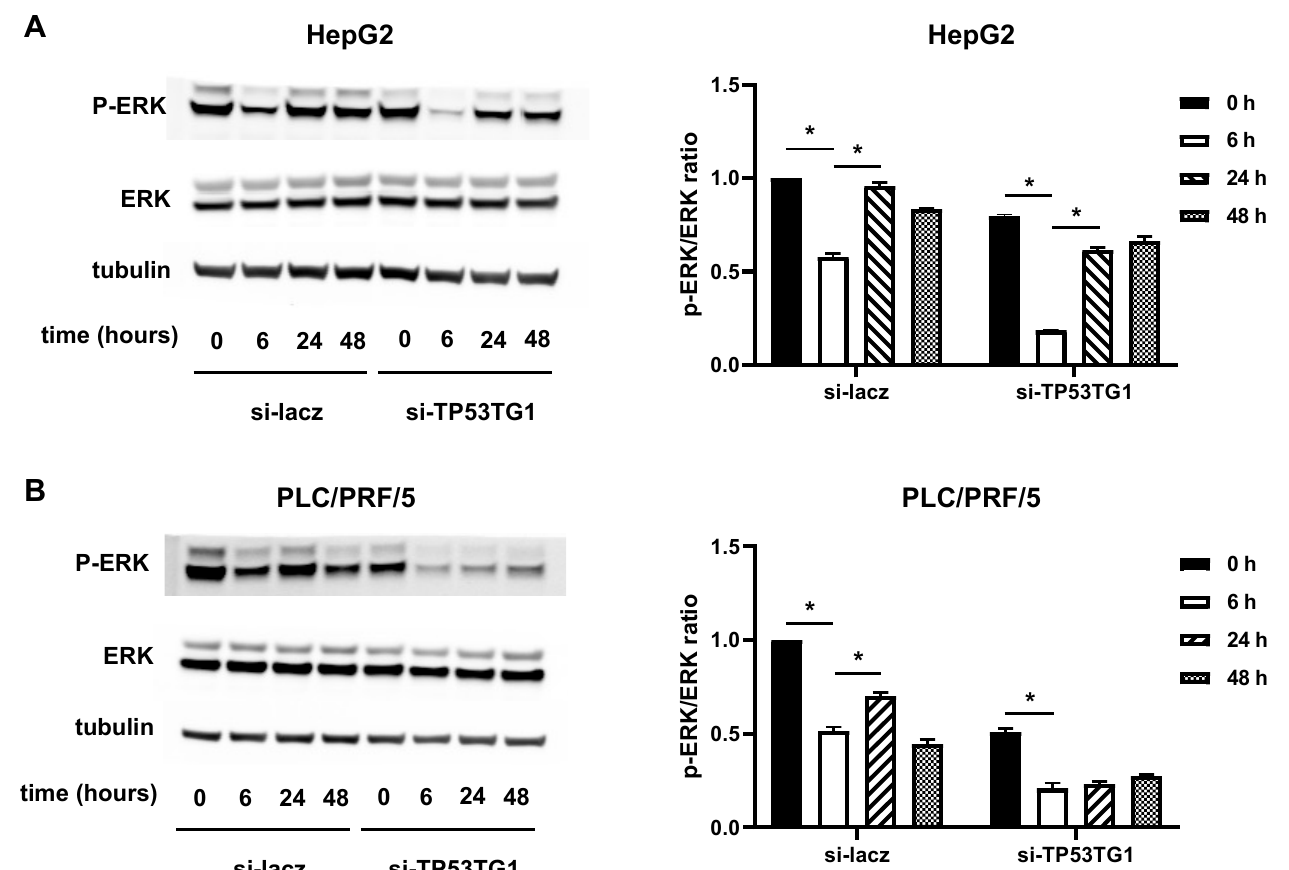
Figure 4. Knockdown of TP53TG1 increases inhibition of ERK activation by sorafenib. ( A , B ) Detection of p-ERK and ERK protein content in ( A ) HepG2 cells and ( B ) PLC/PRF/5 cells treated with 10 µM sorafenib at different time points using western blot. Quantification is shown in the right panel ( n = 3). Error bars are shown as SEM, * p < 0.05.